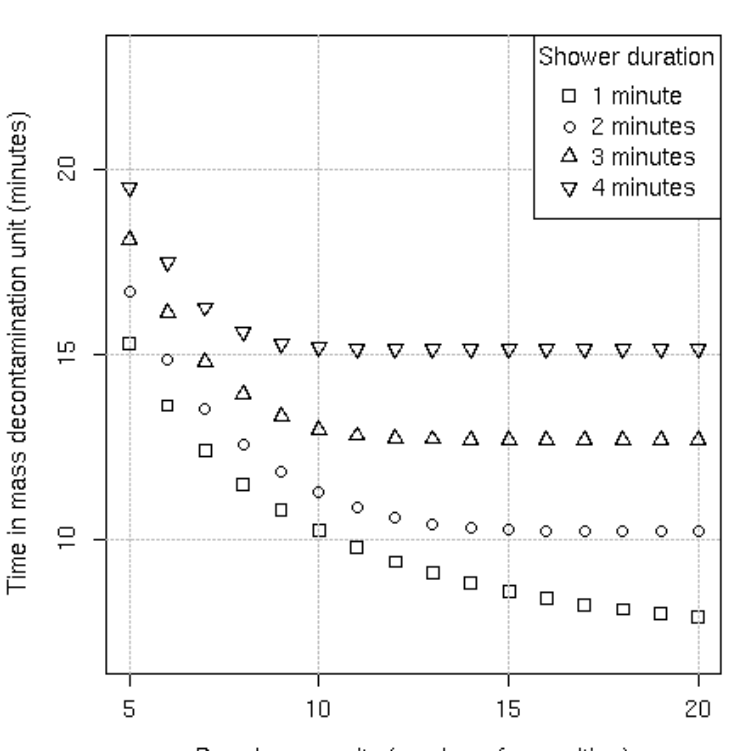
Figure 6. Average simulated results per lane with the baseline re-robe distribution and the exit light